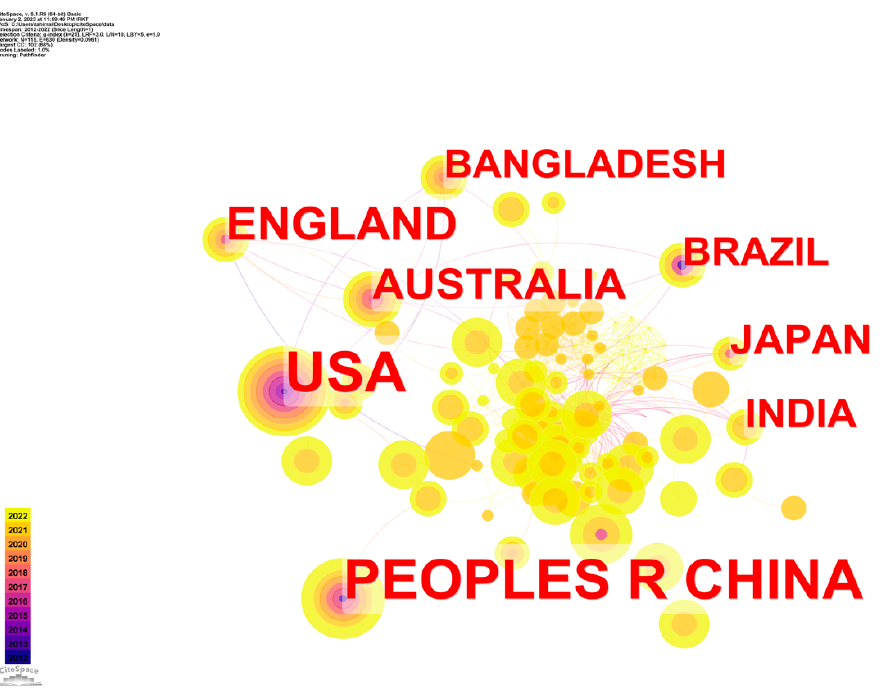
Figure 6. CS map of country–co-authorship studies of epidemic control based on big data research.